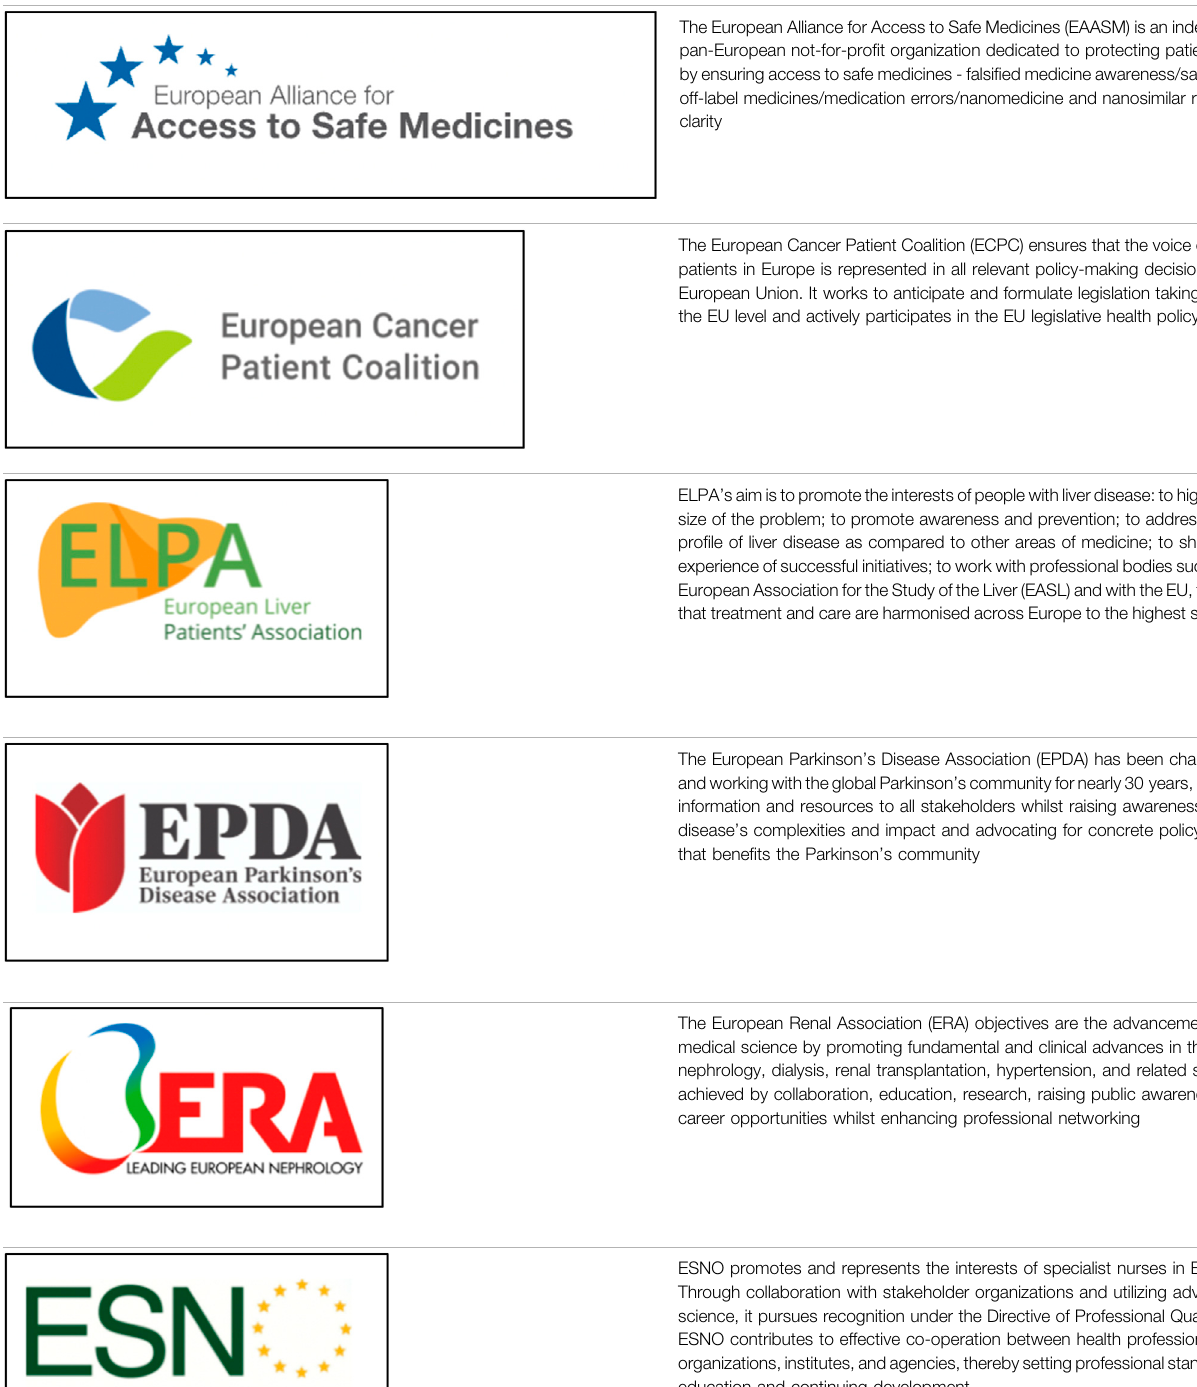
TABLE 3 | Nanomedicines Regulatory